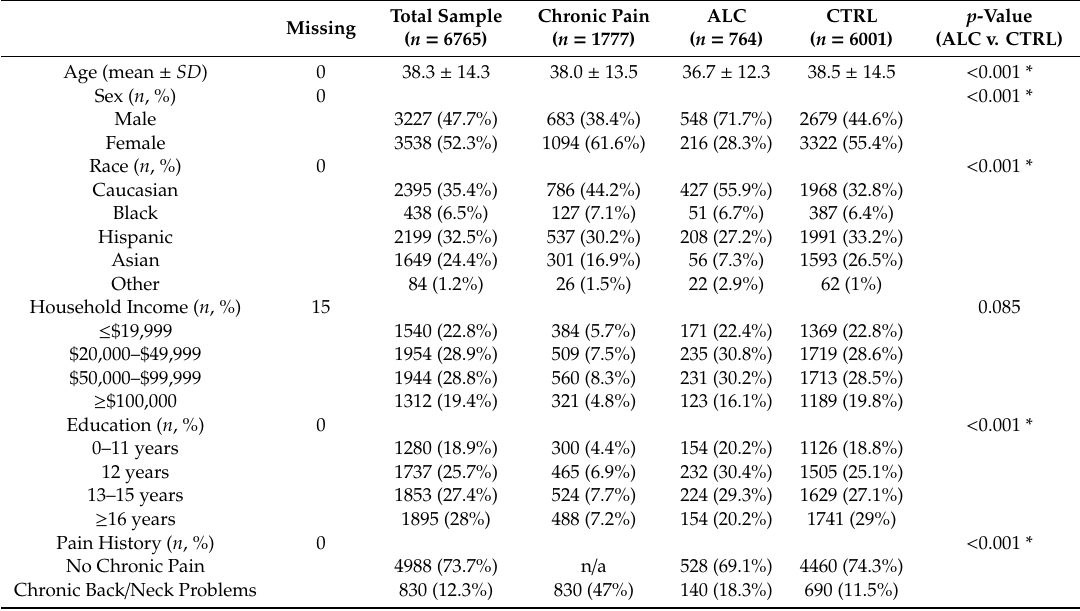
Table 1. Characteristics of the